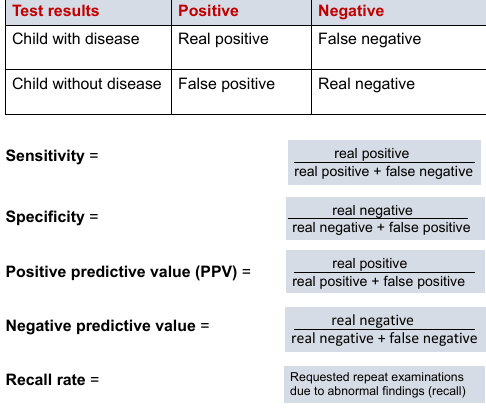
Figure 1. Test results and quality parameters in neonatal screening. Sensitivity: Ability of the test to accurately identify those individuals with a specific condition/disease. Specificity: Ability of the test to accurately identify those individuals without the condition/disease. Positive predictive value (PPV): Probability that the person tested has the disease when the test is positive. Negative predictive value: Probability that the person does not have the disease, when the test is negative.